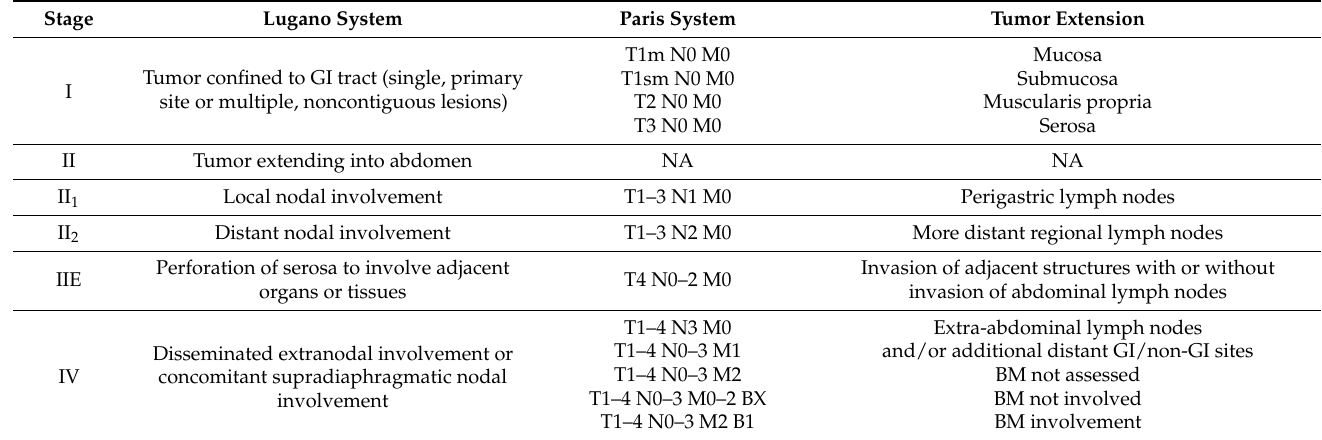
Table 2. Lugano and Paris staging systems for gastrointestinal lymphomas